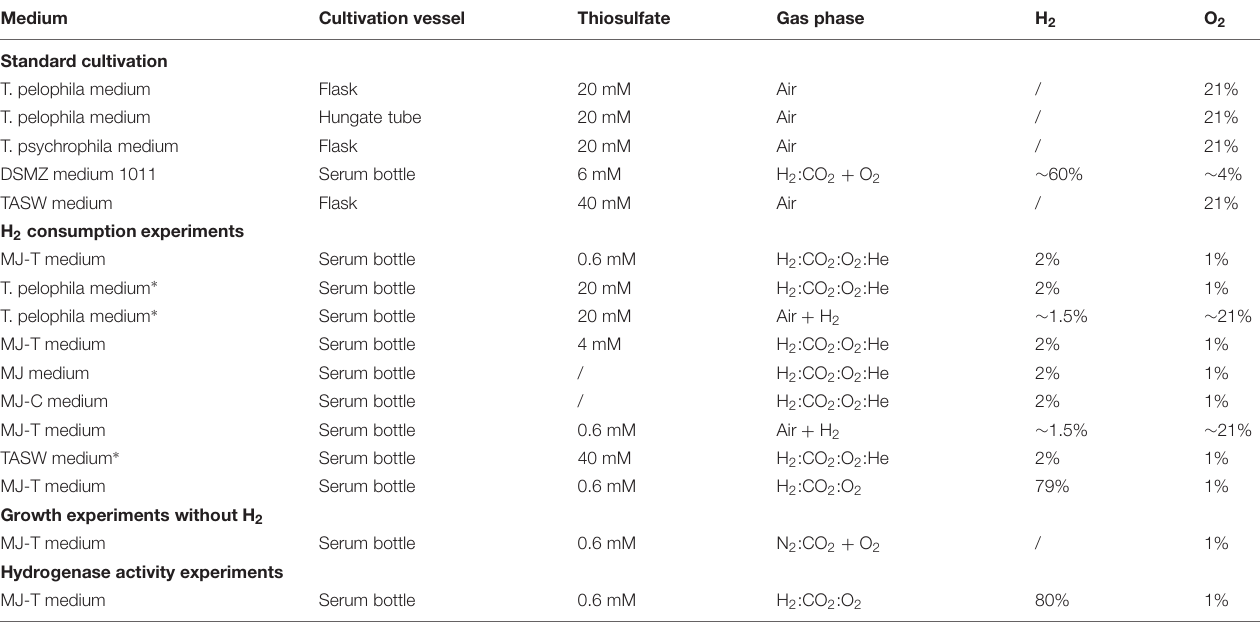
TABLE 1 | Media and cultivation conditions used to grow and investigate the different Thiomicrospira